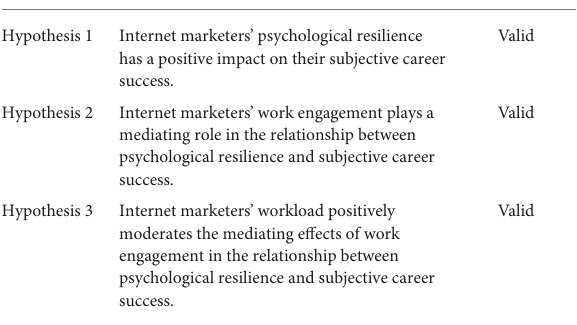
TABLE 8 Research hypotheses and test